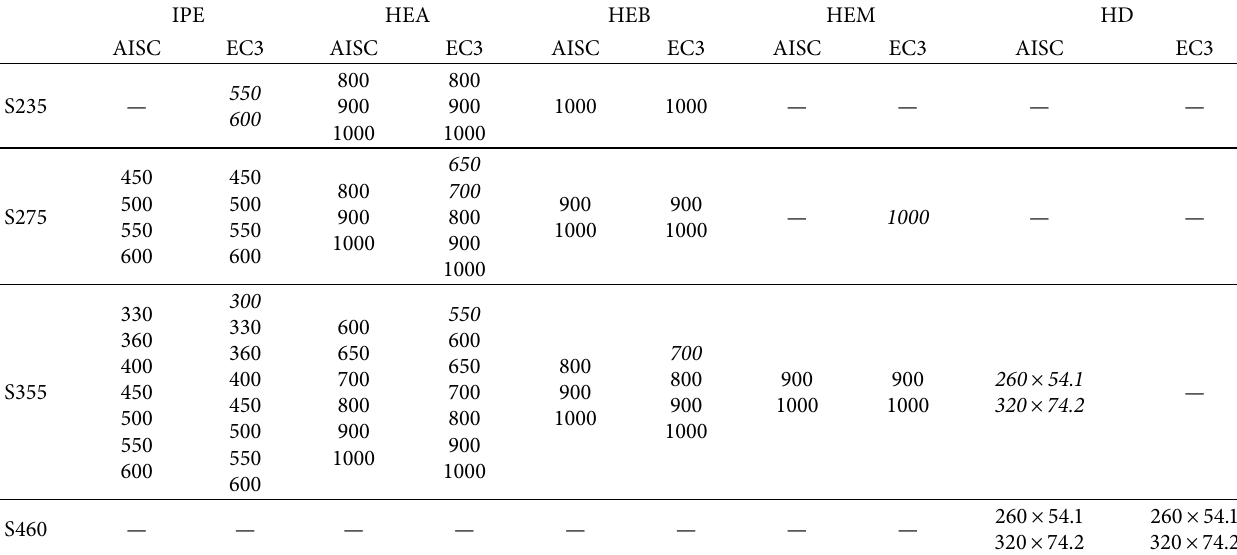
Table 2: The numbers of slender-element sections according to AISC 360-16 and Class 4 sections according to EC3 for the studied steel